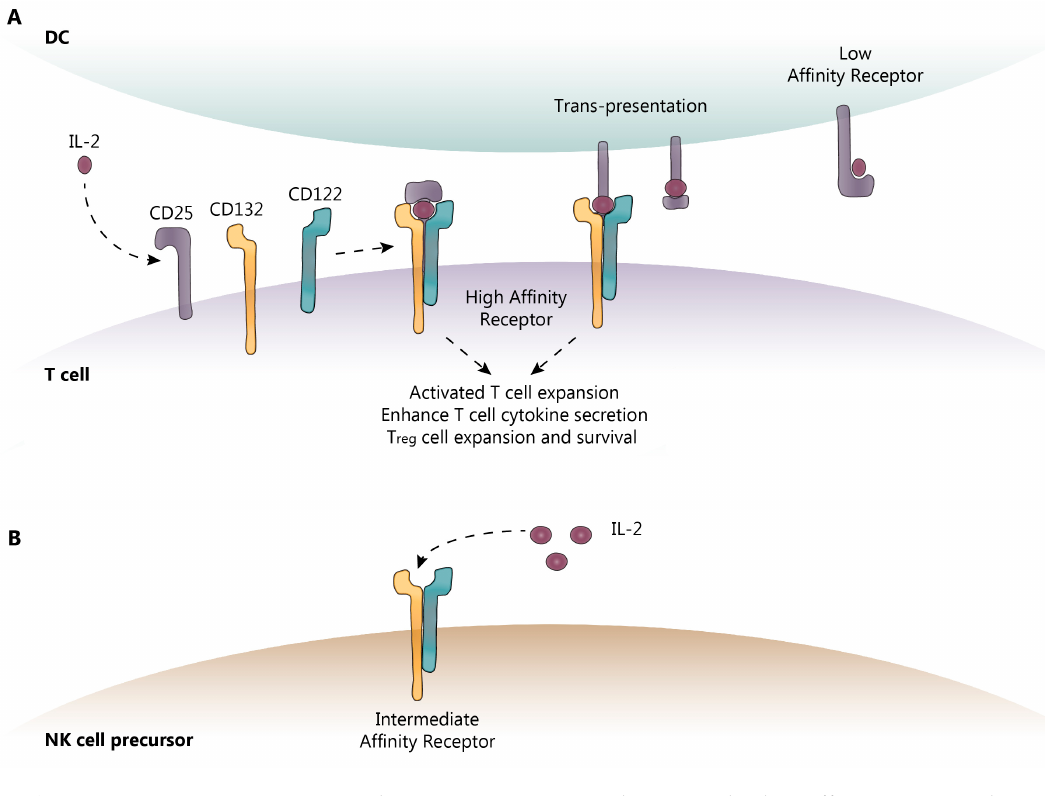
Figure 1. IL-2 receptor (IL-2R) subunits. ( A ) CD25 ( α -subunit) is the low-affinity IL-2R and is expressed on activated T cells, T reg cells, and mDC. Once IL-2 is bound to CD25 on the cell surface, CD132 ( γ ) and CD122 ( β ) are recruited to form the high-affinity IL-2R. CD132 and CD122 are the only subunits capable of intracellular signaling. ( B ) Other cell types such as NK cells express the intermediate-affinity IL-2R, comprised of CD132 and CD122 only. This receptor requires elevated levels of IL-2 for signaling, such as those found in a local draining lymph node, due to reduced binding affinity for IL-2. DC-dendritic cell; IL-2-interleukin-2; NK-natural killer. Dotted lines show the sequence of events following IL-2 binding to its receptor.